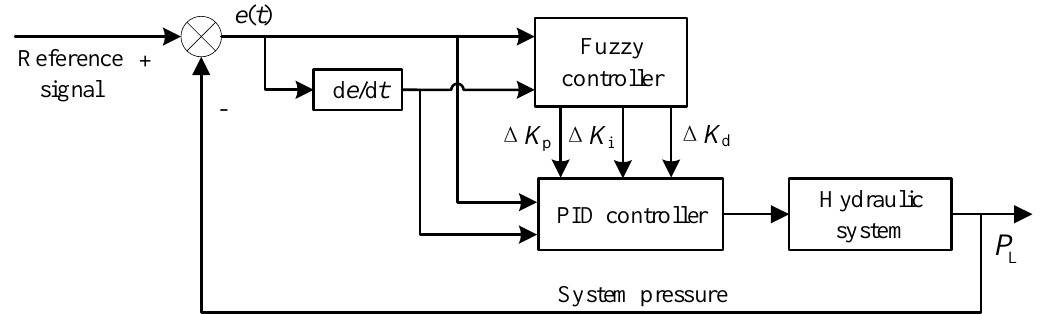
Figure 5. Principle diagram of the adaptive fuzzy PID controller for pressure control.